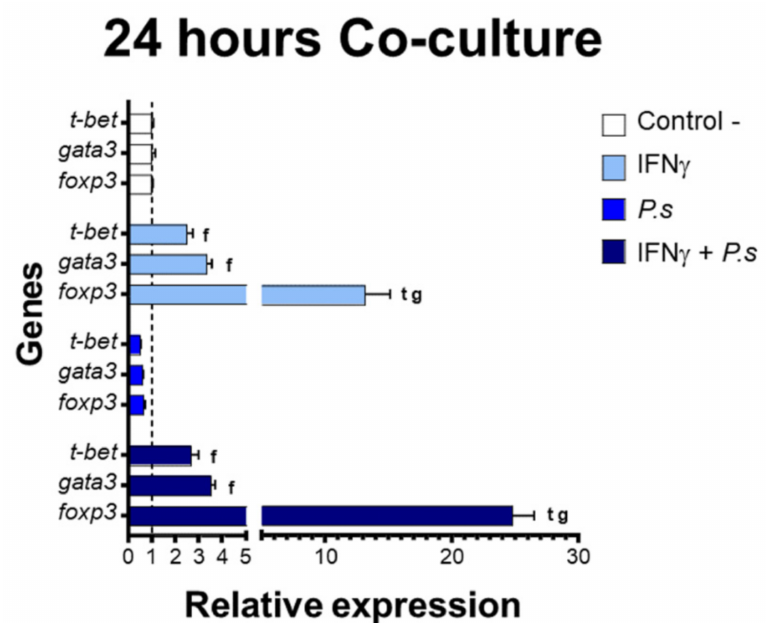
Figure 4. Gene expression presented as fold change relative to controlling T cell transcriptional factors in co-cultures of CD4 + IgM − cells and mononuclear splenocytes MHC + CD83 + , that include MHC − CD83 − cells at 24 h. In white—control without induction (C-). In light blue—co-culture of splenocytes with prior induction with IFN γ . In blue—co-culture of splenocytes with prior induction of P. salmonis ( P.s ). In dark blue—co-culture of splenocytes induced with IFN γ + P. salmonis (IFN γ + P.s ). Each bar: n = 3 fish. Lowercase letters (t, g, and f)—significant differences ( p < 0.05) compared with t-bet , gata3 , and foxp3 ,